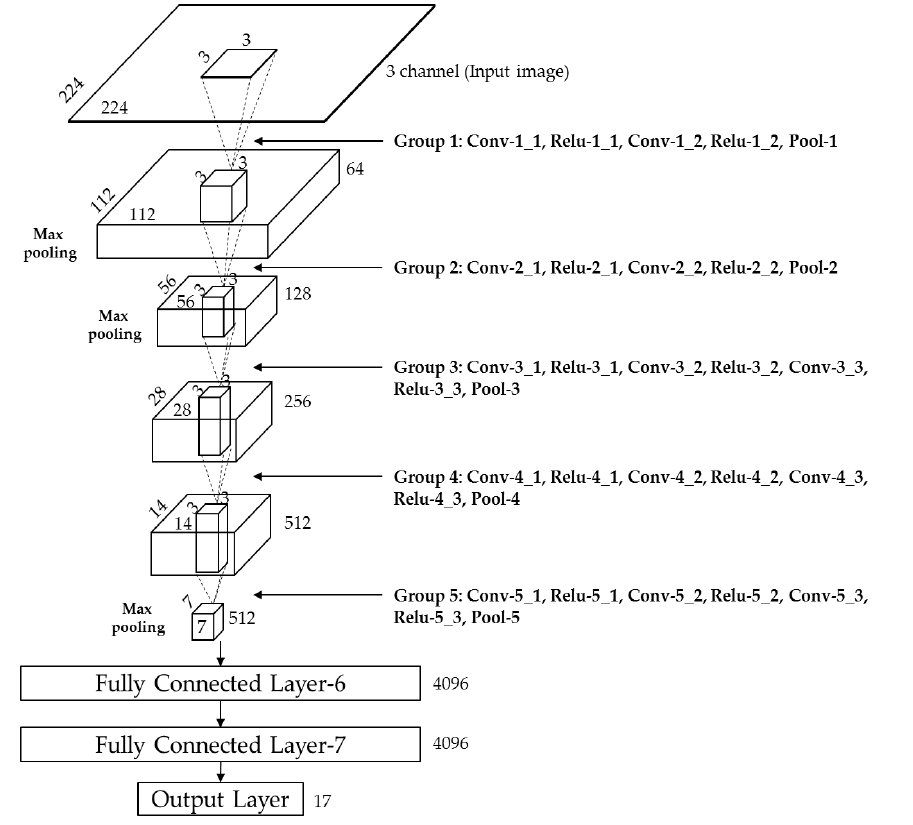
Figure 9. CNN architecture used for finding required gaze features.